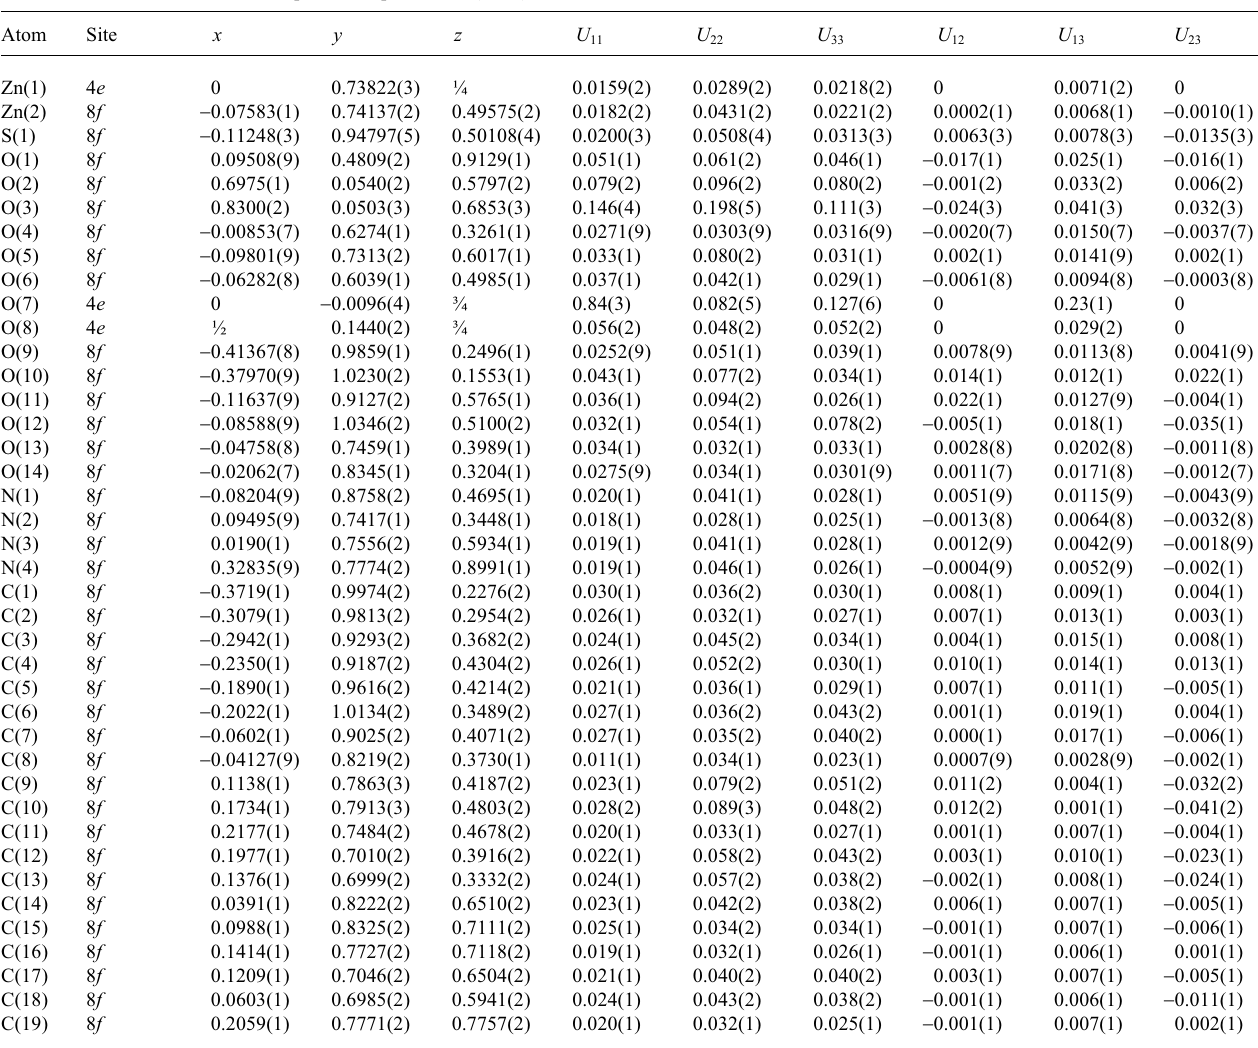
Table 3. Atomic coordinates and displacement parameters (in Å 2 ).